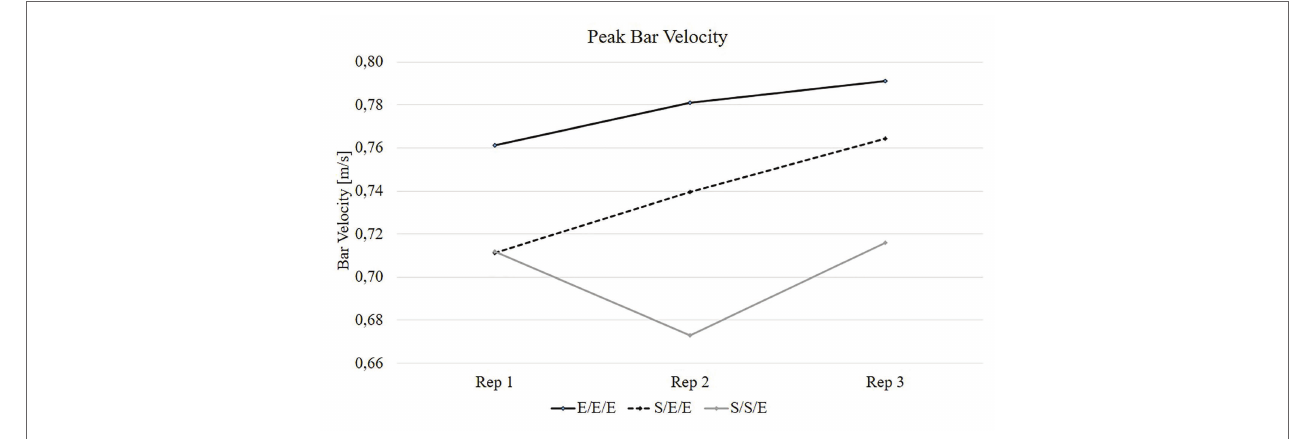
FIGURE 2 | Results of peak bar velocity for the three experimental movement tempos. E/E/E – 1st repetition explosive, 2nd repetition explosive, 3rd repetition explosive; S/E/E – 1st repetition slow, 2nd repetition explosive, 3rd repetition explosive; S/S/E – 1st repetition slow, 2nd repetition slow, 3rd repetition